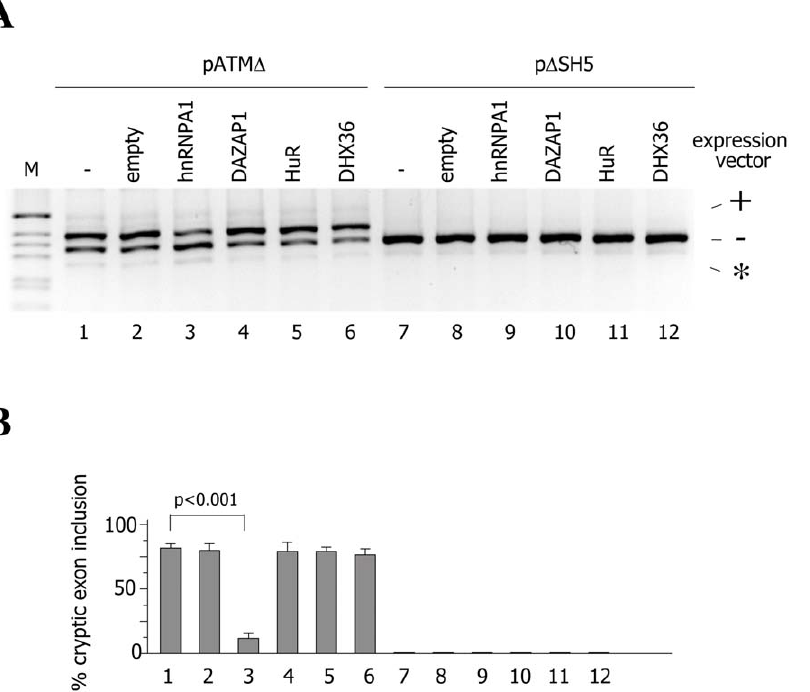
Figure 2. Effect of RNA helicase DHX36, DAZAP1, HuR and hnRNPA1 overexpression on ATM cryptic exon activation of pATM D and p D SH5 minigenes. (A) HeLa cells were transfected with pATM D and p D SH5 minigenes in presence of empty expression vector (lanes 2 and 8, respectively) or vectors expressing the protein of interest (lanes 3-6 and 9-12, respectively). The splicing pattern was analyzed with the E16 and 2550 primers. RT-PCR fragments were resolved on 2% agarose gel. M is the molecular weight marker. On the right is indicated the splicing product with ( + ) or without (-) cryptic exon inclusion. The asterisk corresponds to a minor spliced product without the hybrid exon made of globin exon 3 and ATM exon 20. (B) The graph is the quantification of three independent experiments expressed as means 6 SD.